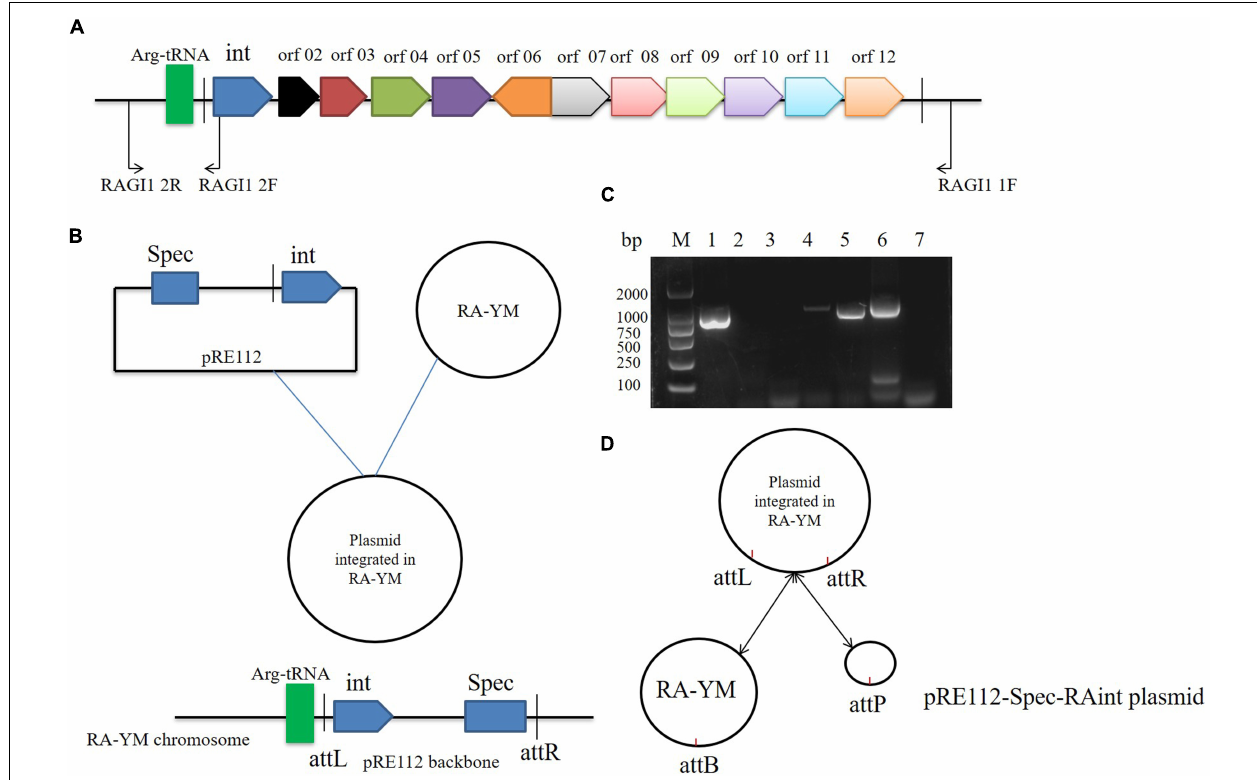
FIGURE 3 | Integrase mediated integration and excision. (A) Primer designed for integrase cloned. (B) The vector construction and integration mechanism. (C) Integrase mediated integration and excision in R. anatipestifer RA-YM strain and R. anatipestifer YMint strain. Lane 1, PCR for integration with RAGI1 1F/2R primer pair in R. anatipestifer RA-YM strain; Lane 2, PCR for excision with RAGI1 2F/2R primer pair in R. anatipestifer RA-YM strain; Lane 3, PCR for Spec R resistant gene with Spec R F/R primer pair in R. anatipestifer RA-YM strain; Lane 4, PCR for integration with RAGI1 1F/2R primer pair in R. anatipestifer YMint strain; Lane 5, PCR for excision with RAGI1 2F/2R primer pair in R. anatipestifer YMint strain; Lane 6, PCR for Spec R resistant gene with Spec R F/R primer pair in R. anatipestifer YMint strain; Lane 7, negative control; M, DL2000 DNA marker. (D) Integrase mediated integration and excision model. The dynamic balance of pRE112-Spec-RAint suicide plasmid integration and excision in R. anatipestifer RA-YM